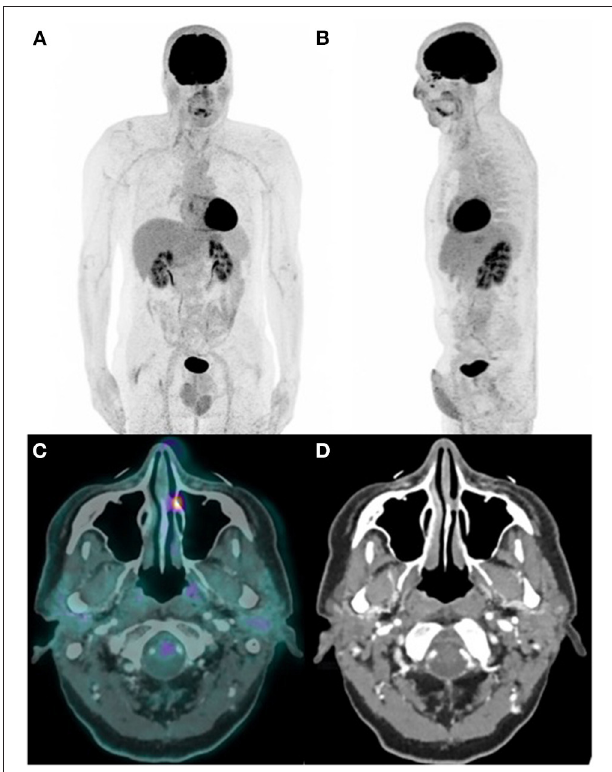
FIGURE 1 | Fluoro-D-glucose PET/CT (FDG-PET/CT) images. (A,B) PET MIP (C) fused PET/CT, and (D) CT.